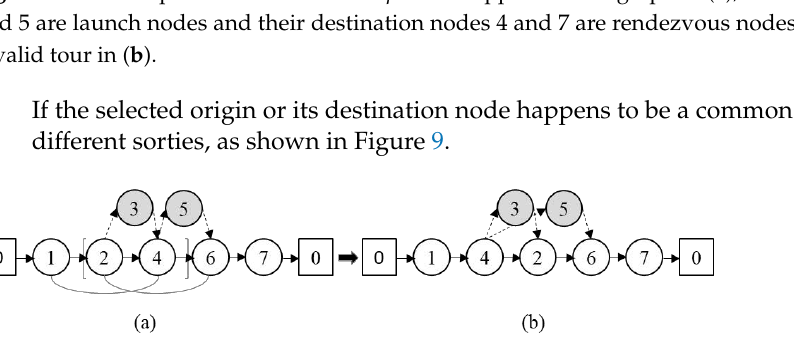
Figure 9. An example of an invalid TwoOpt move applied to the graph in ( a ), where destination node 4 is a launch and rendezvous node for different sorties, resulting in an invalid tour in ( b